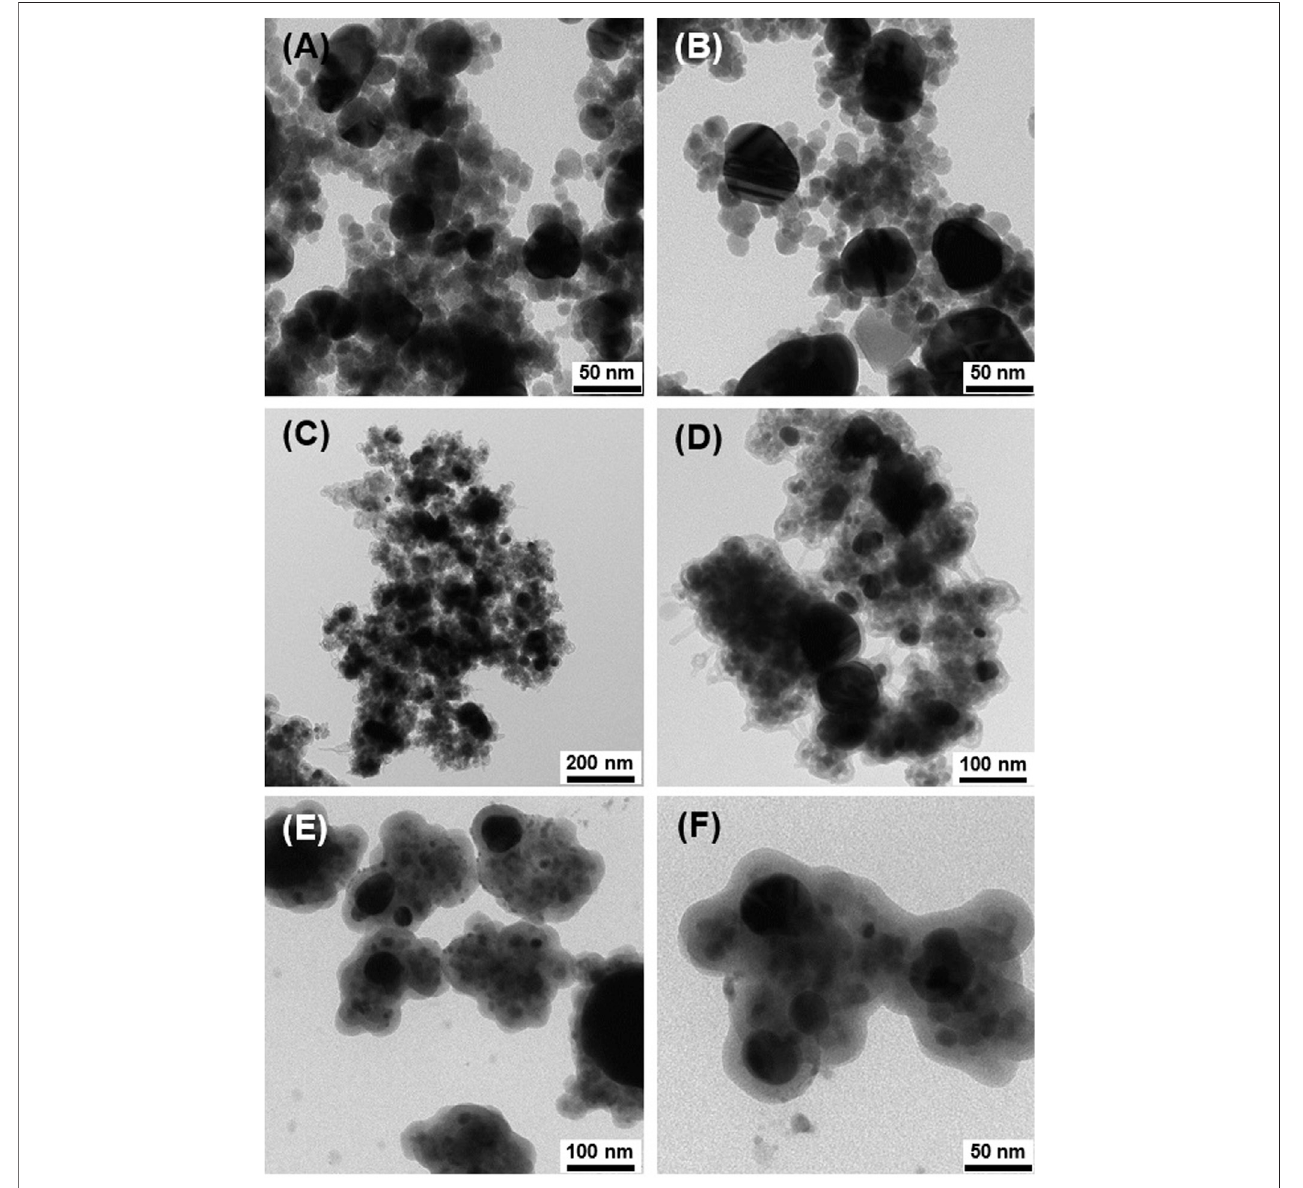
FIGURE 6 | TEM images of Fe 3 O 4 /Ag nanocomposite synthesized with 2 mg/5 ml of magnetite NPs, 1:1 Ag + to n -ButNH 2 molar ratio and 8 mM AgNO 3 (A) and next subjected to Stöber reaction: (B) without MES and without PE, (C,D) with MES and with PE; (E,F) with MES and without PE layer.